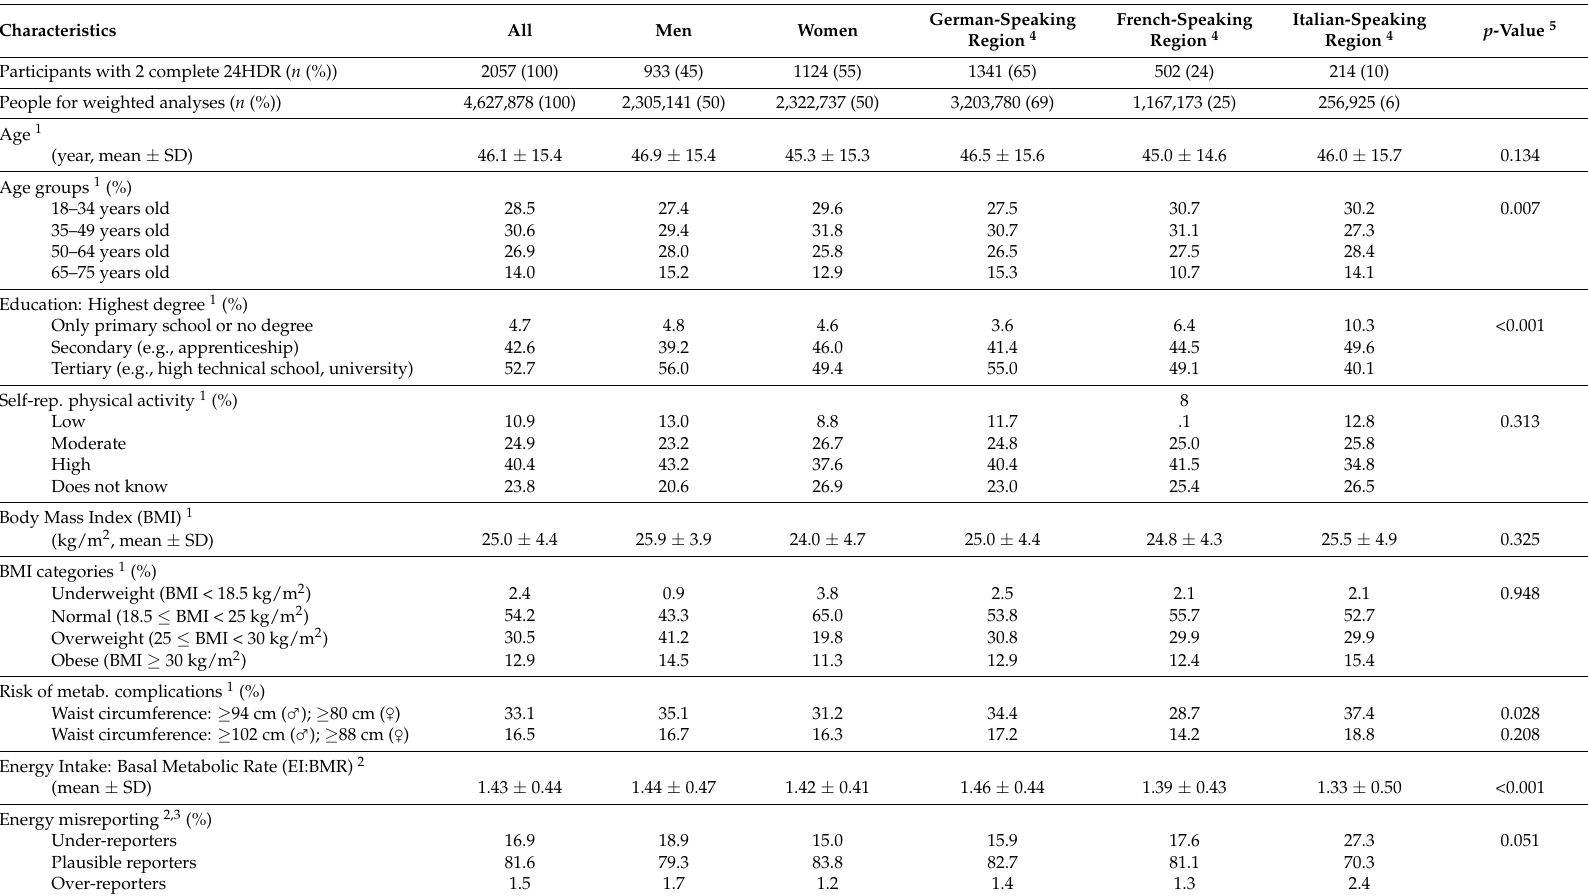
Table 2. Description of participants, by sex and linguistic region, Swiss Nutrition Survey,